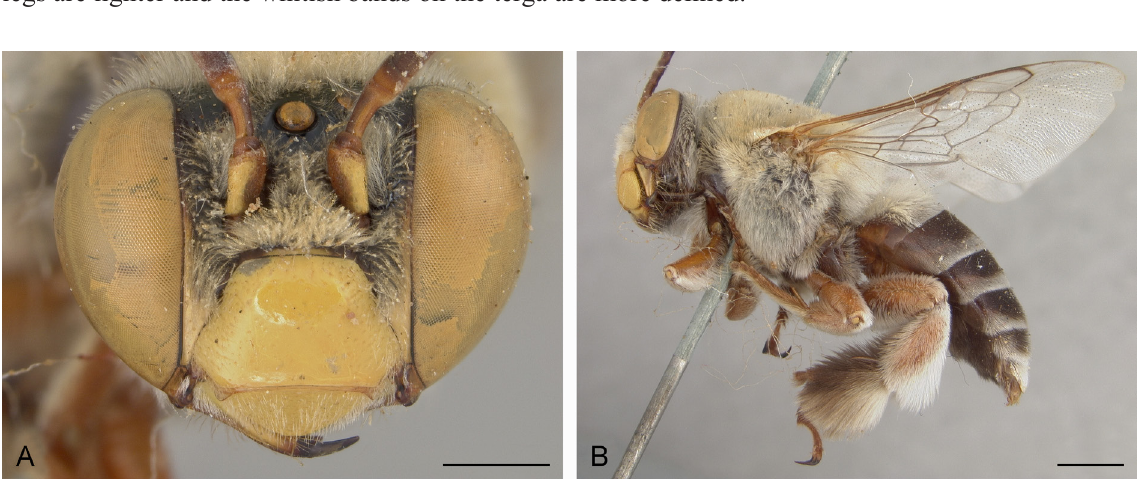
Fig. 24. Centris rhodopus pulchrior Cockerell, 1900, holotype, ♂ (NMNH; USNM ENT 00534208). A . Frontal view. B . Habitus, lateral view. Scale bars: A = 1 mm; B = 2